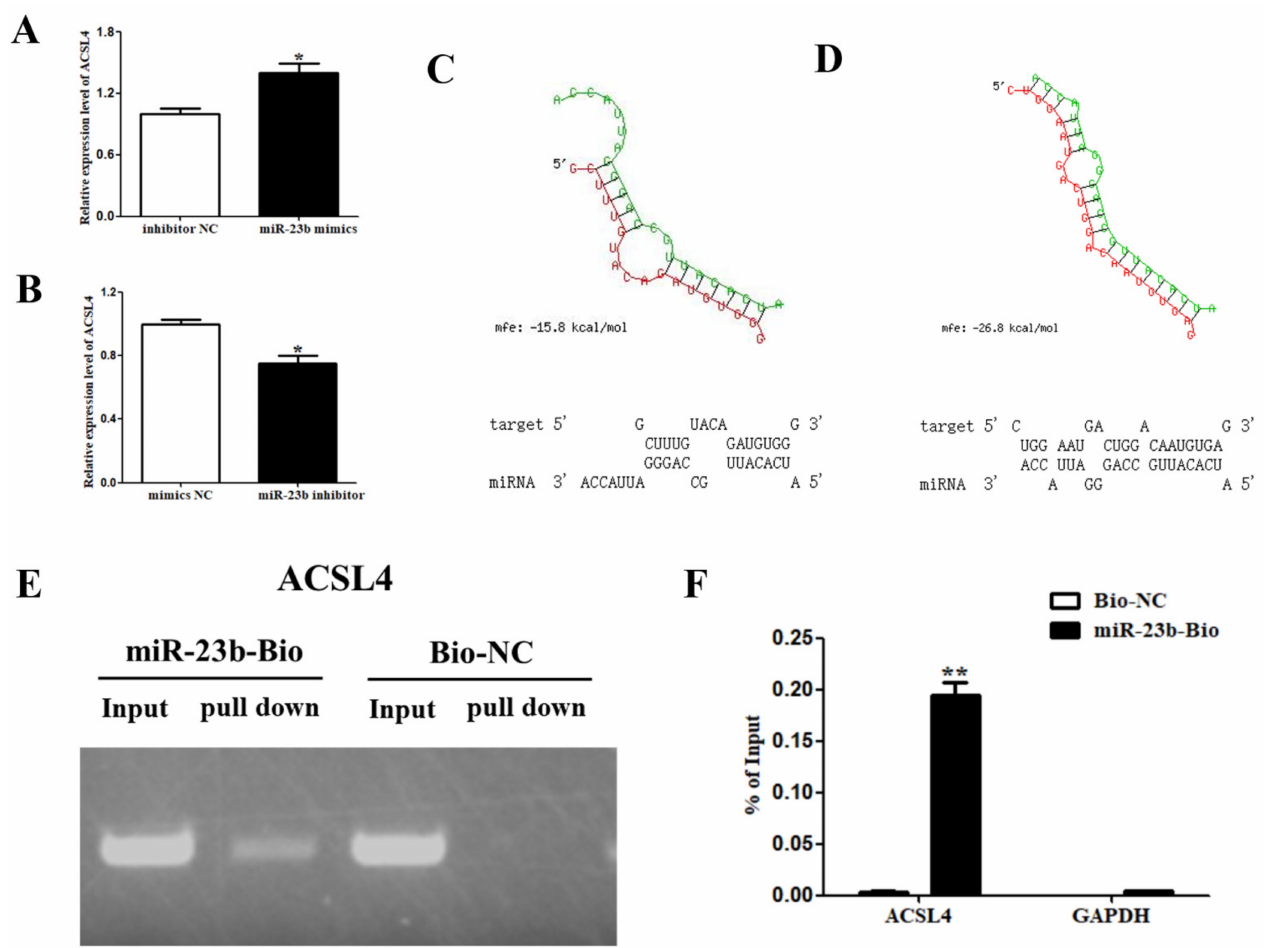
Figure 6. Regulatory relationship between miR-23b and ACSL4 . ( A , B ) ACSL4 expression changes following transfection with miR-23b mimics or inhibitor; ( C , D ) RNhybrid was used to predict binding sites of ACSL4 and miR-23b; ( E , F ) the results of miR-23b pulldown. Note: * indicted significant difference at 0.05 level, and ** indicted significant difference at 0.01